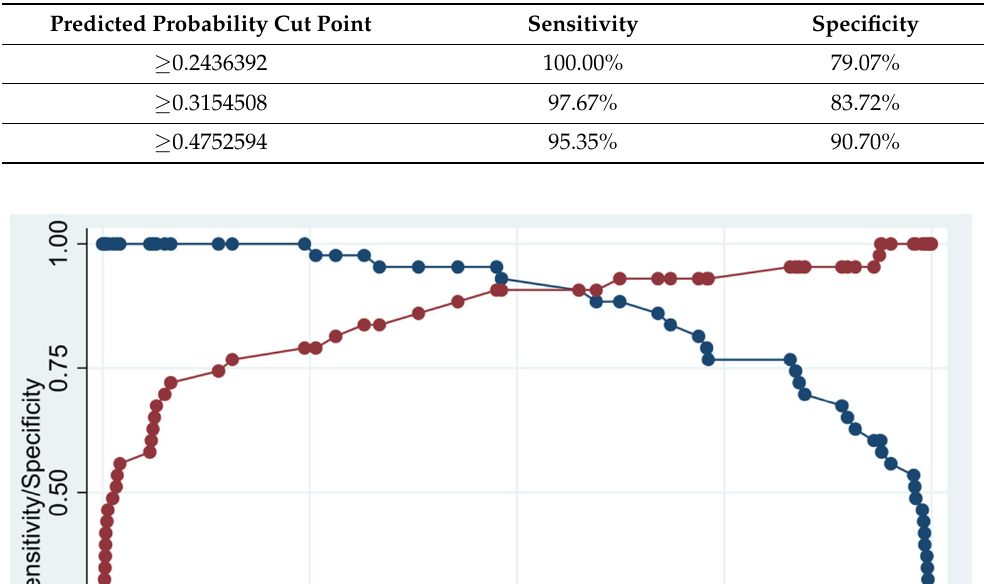
Note: OR = Odds Ratio; CI = Confidence Interval; Coefficient = logistic regression model coefficient. Table 11. Joint panel: sensitivity/specificity plot for the resulting multivariate logistic regression model, and for sensitivity levels higher than specificity levels.